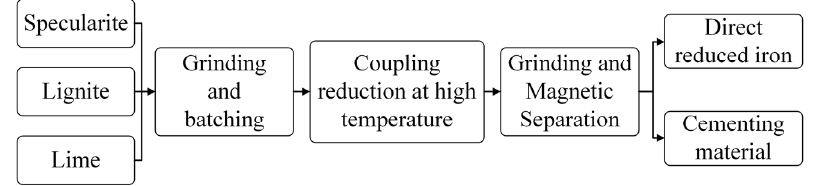
Figure 1. Flow chart of the comprehensive utilization of no - solid-waste resources of